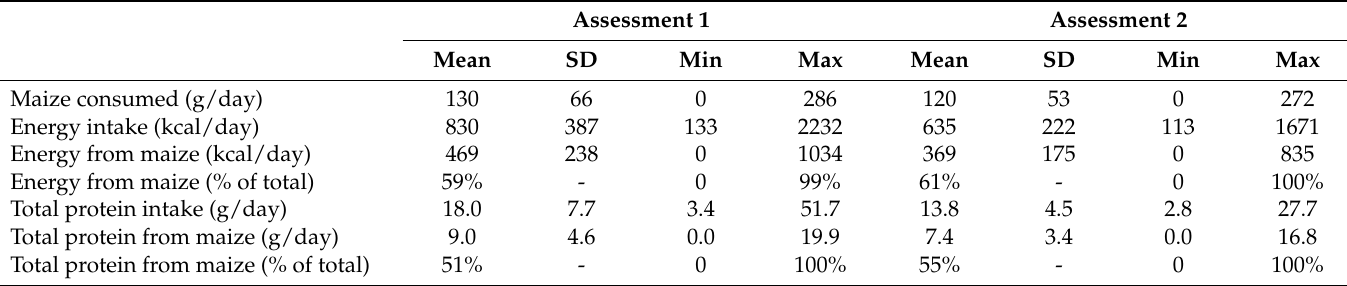
Table 3. Contribution of maize to children’s diets from complementary feeding. Breastmilk intake is not included.